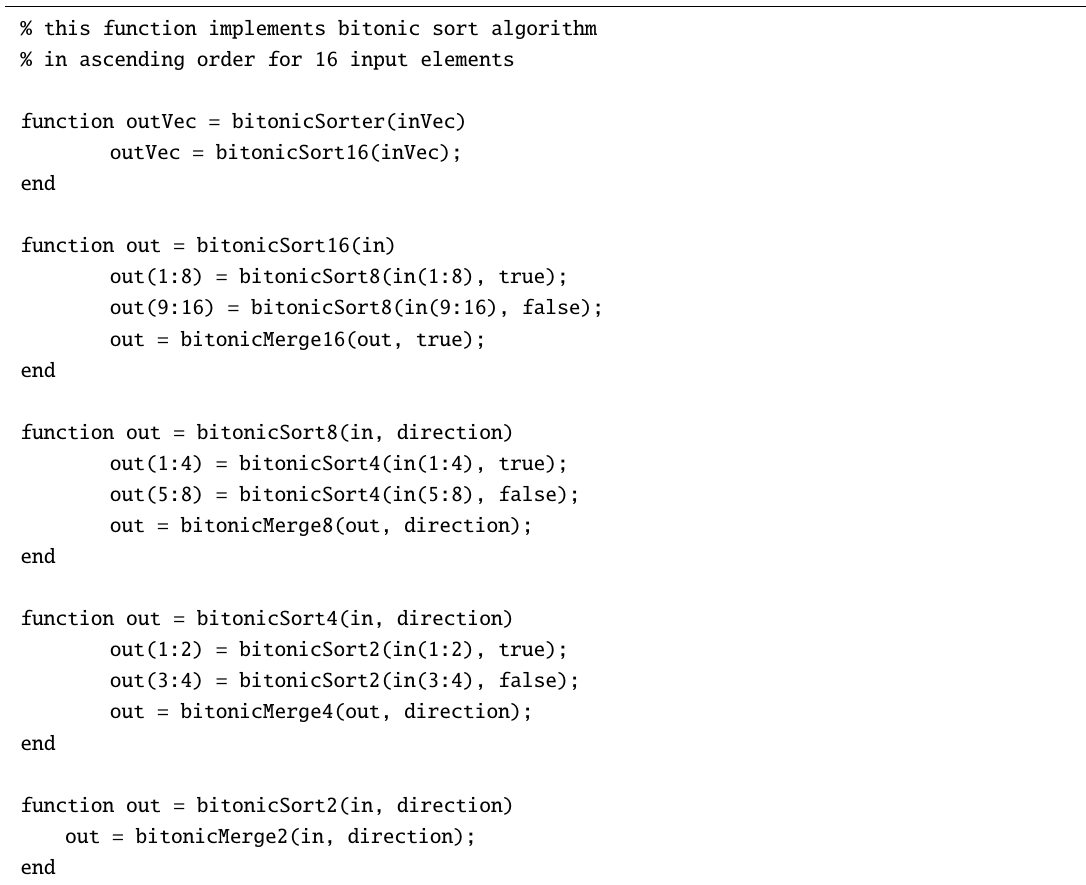
Algorithm 1. Matlab code of Bitonic Sort